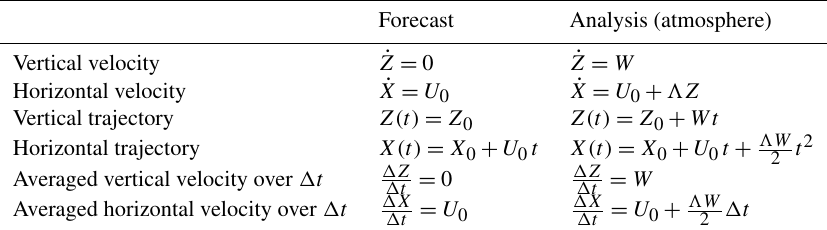
Table B1. Analytical trajectory of a bubble in an idealized sheared wind profile: U(z) = U 0 + (cid:51)z with (forecast) or without (analysis) vertical ascent, and the resulting average